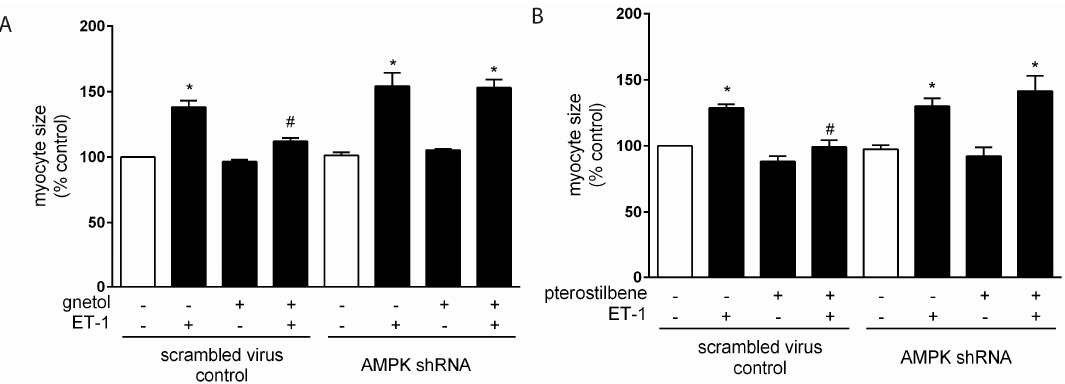
Figure 4. shRNA knockdown AMPK α abolishes gnetol and pterostilbene effects. Following simultaneous knockdown of AMPK α 1 and AMPK α 2 , the catalytic subunits of AMPK, myocytes were exposed to gnetol or pterostilbene for 1 h, followed by addition of ET-1 (0.1 µM) for 24 h. Upon addition, all compounds remained in the culture media for the remainder of the experiment. AMPK α knockdown abrogated the ability of ( A ) gnetol (5 µg/mL); and ( B ) pterostilbene (1 µg/mL) to abolish ET1-induced myocyte enlargement. n = 3. * p <0.05 vs. control (open bars); # p < 0.05 vs. ET1.